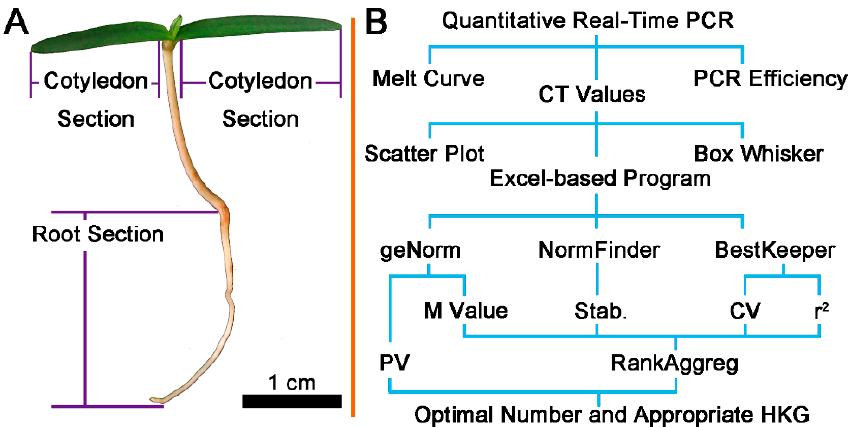
Figure 1. Sample sets and data analysis flow chart: ( A ) different section of Chinese fir used in experiment; and ( B ) data analysis flow chart. Cycle threshold ( C t ) values were calculated using different algorithms. Each candidate HKG has one efficiency value. The C t data were checked for distribution by scatter plot and box whisker. The statistical results from three excel-based program were merged with RankAggreg. Abbreviations: Stab.: NormFinder stability value; r 2 : determination coefficient-regression from BestKeeper; CV: coefficient of variance from BestKeeper; M: classical stability value from geNorm; PV: pairwise variation from geNorm.